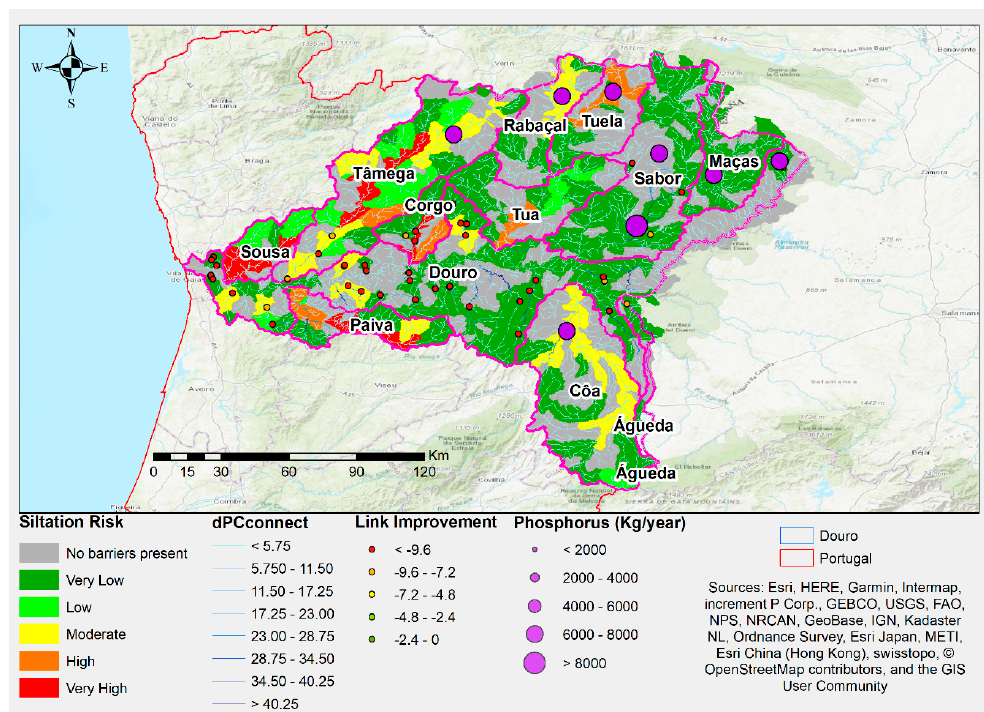
Figure 6. Analysis of the silting risk map together with the priority removal barriers and with the basins with higher phosphorus values.